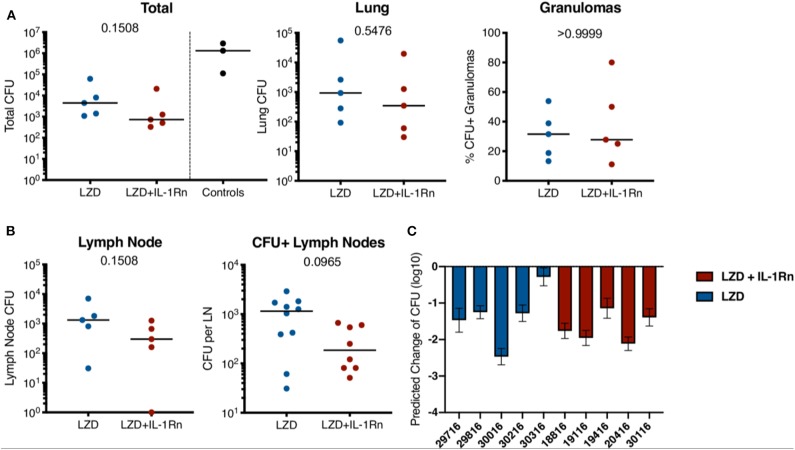
Addition of IL-1Rn does not modify efficacy of LZD-bacterial killing. Bacterial burden is shown after 4 weeks of LZD (blue) or LZD+IL-1Rn (red) treatment. (A) Total thoracic (lung + lymph nodes) and lung CFU; each data point represents one macaque. Total thoracic CFU from three similarly infected untreated historical control macaques (black) are included as reference for untreated CFU at this time point but excluded from statistical analysis. Lung (granulomas and lung tissue) are shown separately. The percent of all lung granulomas that were CFU+ per monkey is shown. (B) CFU of all thoracic lymph nodes with data points representing CFU from one macaque. CFU+ lymph nodes show the CFU from each thoracic lymph node in any animal that was Mtb+. For (A,B), p-values were determined by Mann-Whitney test. (C) PET CT scans from pre-treatment were used to model predicted CFU prior to HDT initiation and compared to actual CFU determined at time of necropsy. The predicted change in CFU was determined by: Actual total thoracic CFU post-treatment—Predicted total thoracic CFU interval (predicted from pre-drug-treatment scan). Bars represent mean of prediction intervals and error whiskers represent the lower and upper bounds of the difference between final total CFU and predicted CFU prior to drug treatment.